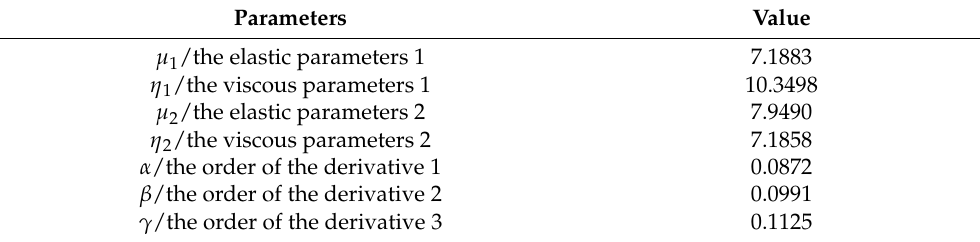
Figure 4. Characterization of stiffness and loss factor of the rail pad; ( a ) stiffness; ( b ) loss factor. Table 1. Parameter values of model of rail pad.